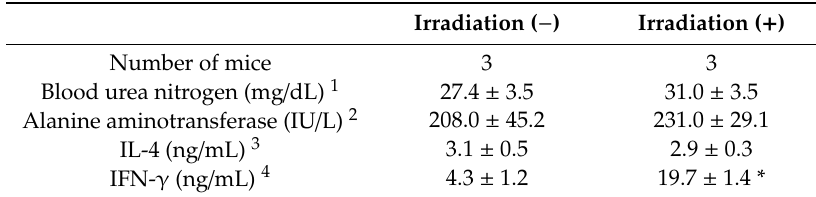
Table 1. E ff ects of 4 Gy of total body irradiation on organ damage and cytokine levels after alpha-galactosylceramide